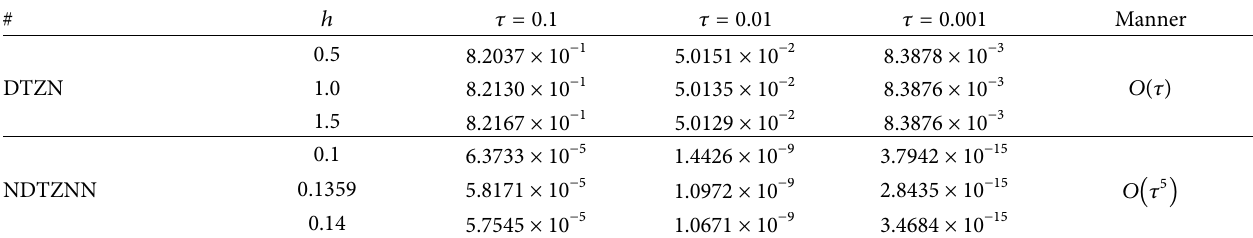
Figure 2: The trajectories generated by DTZN and NDTZNN.